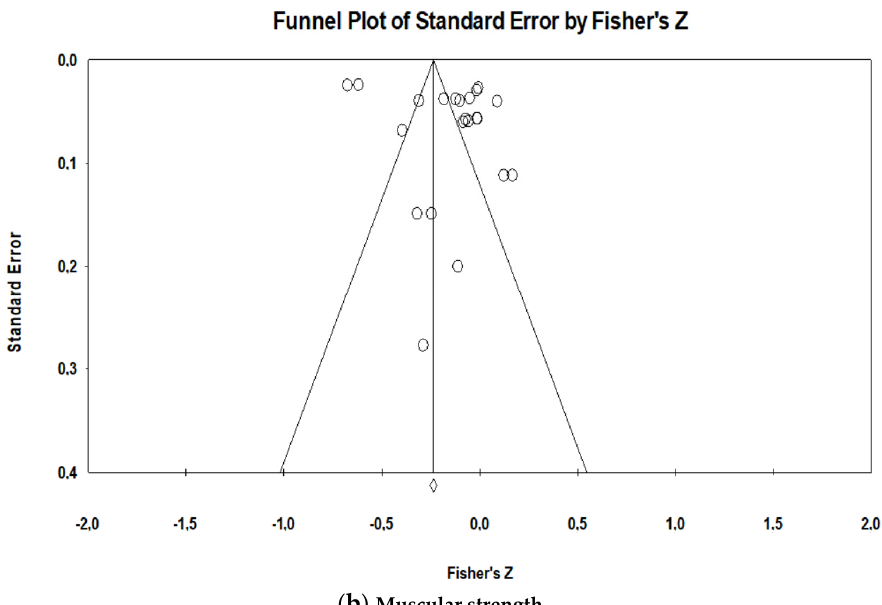
Figure 3. Visual funnel plot inspection associated with Egger’s test for the association between objectively measured total ST and physical fitness components; ( a ) cardiorespiratory fitness; ( b ) muscular strength.